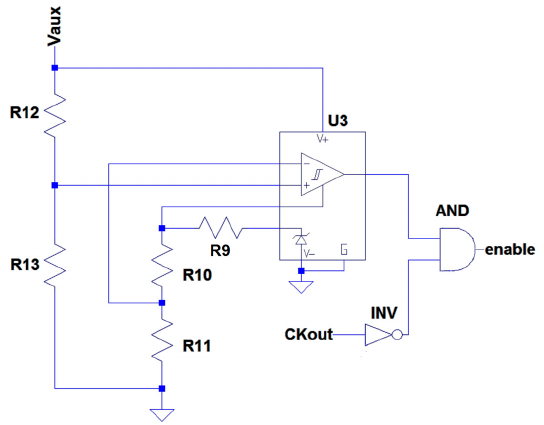
Figure 12. Charging control module. Resistors R9–R13 set up the thresholds to enable the supercap charging switch S2. J. Sens. Actuator Netw. 2016 , 5 , 15